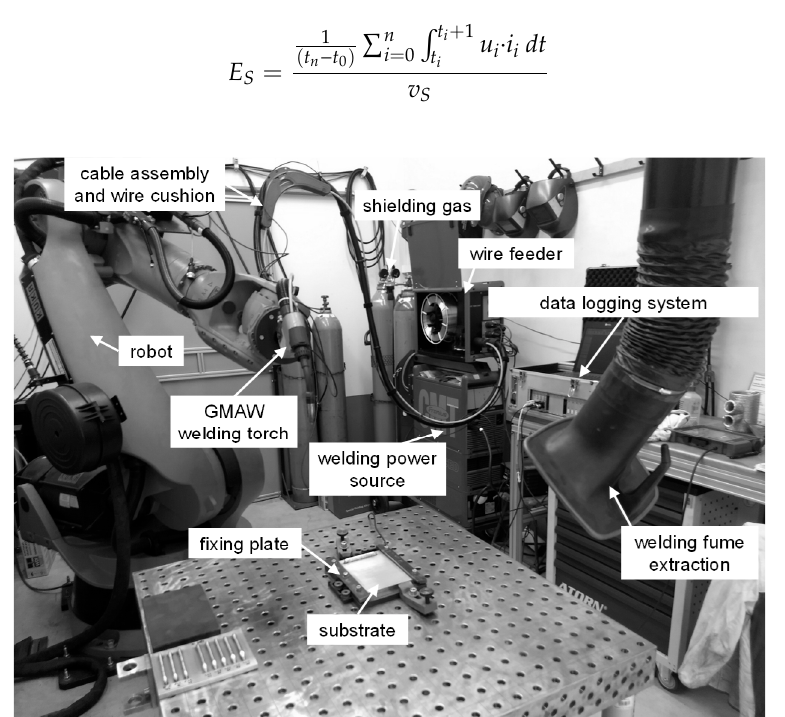
Figure 1. Experimental setup for the experimental trials using gas metal arc welding (GMAW).